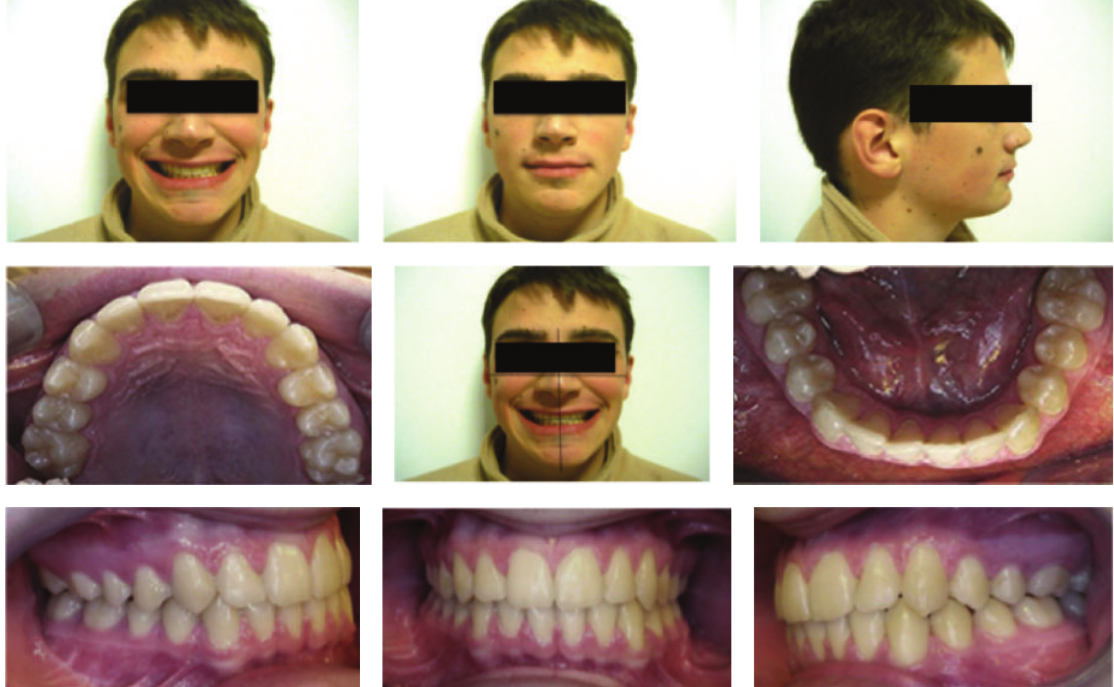
Figure 10: Curve of Wilson and Spee at the end of the finishing and detailing phase. (a) Curve of Wilson; (b) curve of Spee in the right side; and (c) curve of Wilson in the left side.